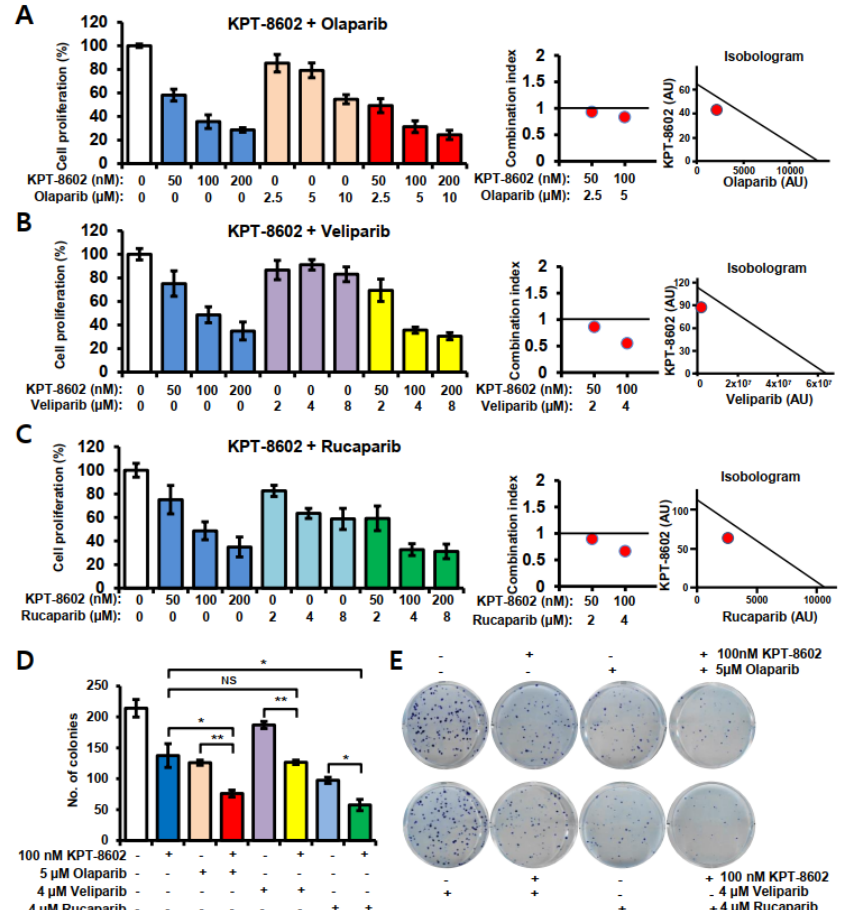
Figure 1. KPT-8602 with PARP inhibitors induced growth inhibition of 22rv1 prostate cancer cells. ( A – C ) 22rv1 cells were treated with 50–200 nM doses of KPT-8602 or 2–10 µ M doses of olaparib, veliparib and rucaparib for 72 h. MTT assay was performed to determine the growth inhibition. Left panel is the growth inhibition bar diagram with single or combinations of KPT-8602 and PARP inhibitors. Middle and right panels are the corresponding combination indexes and isobolograms of A–C, respectively, which were generated using Calcusyn 2.1 software. ( D – E ) Colony formation with single or combinations of KPT-8602 and PARP inhibitors. D. Bar diagram showing the number of colonies with indicated doses of KPT-8602 or PARP inhibitors. E. Representative plates showing colonies with either alone or a combination of KPT-8602 and PARP inhibitors. All experiments have been done at least thrice. Error bars represent standard deviation. NS, not significant; * p < 0.05; ** p < 0.01.